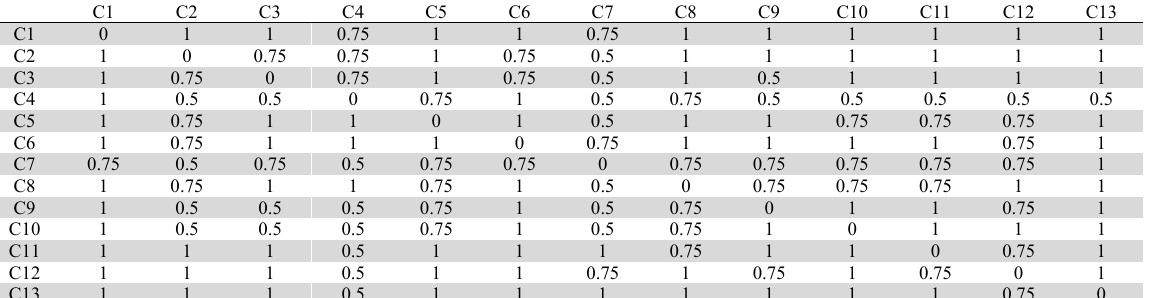
Normalized initial direct-relation fuzzy matrix (m)